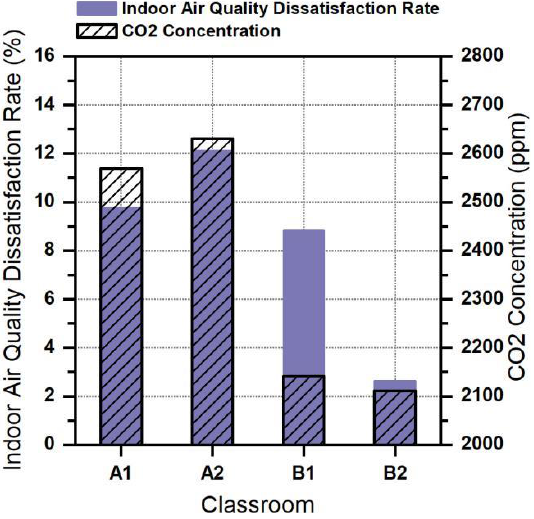
Figure 14. The dissatisfaction rates and CO 2 concentration during the measurement period.